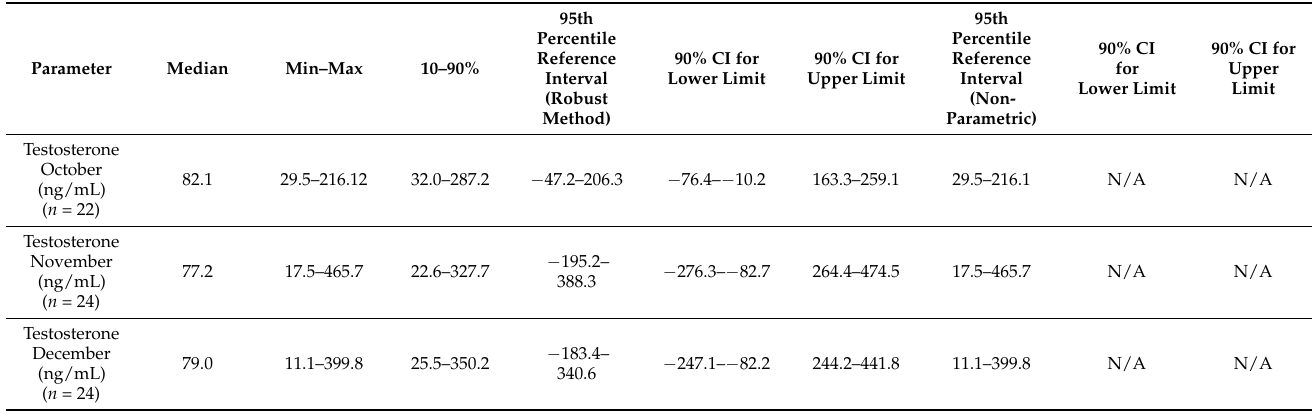
Table 10. Leopard gecko testosterone concentration reference intervals for October, November, and December in the Northern hemisphere. Testosterone concentrations were not found to meet the assumption of normality and are reported by the median, 10–90%, minimum–maximum values, 95% reference intervals, using both the robust and nonparametric methods, and the 90% confidence intervals for the upper and lower limits of the reference interval nonparametric and minimum–maximum values. The nonparametric data are preferred for these reference